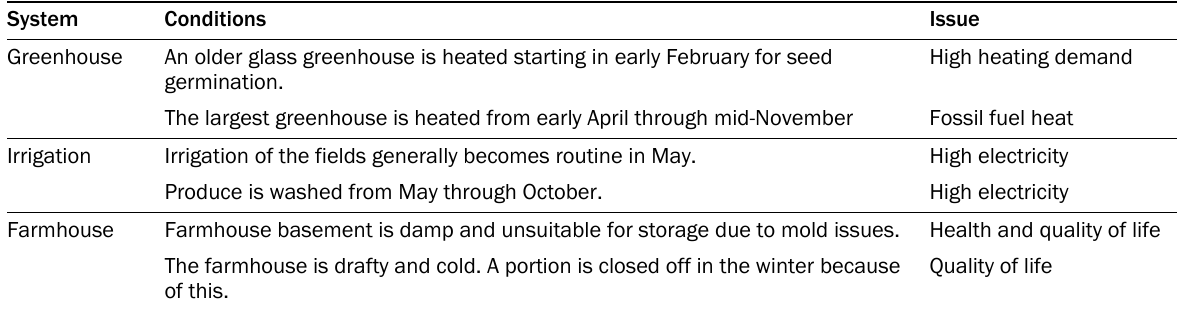
Table 1. Farm System Information for Beech Hill Farm Energy Demonstration Project System